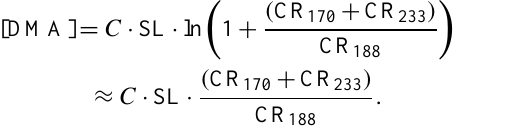
(cid:113) (cid:113) (DMA) ions. (HNO 3 ) 0 − 3 3 ) , ∼ 2600cps (for 3 (cid:113) (HNO 3 ) 2 ) . The colors in- 3